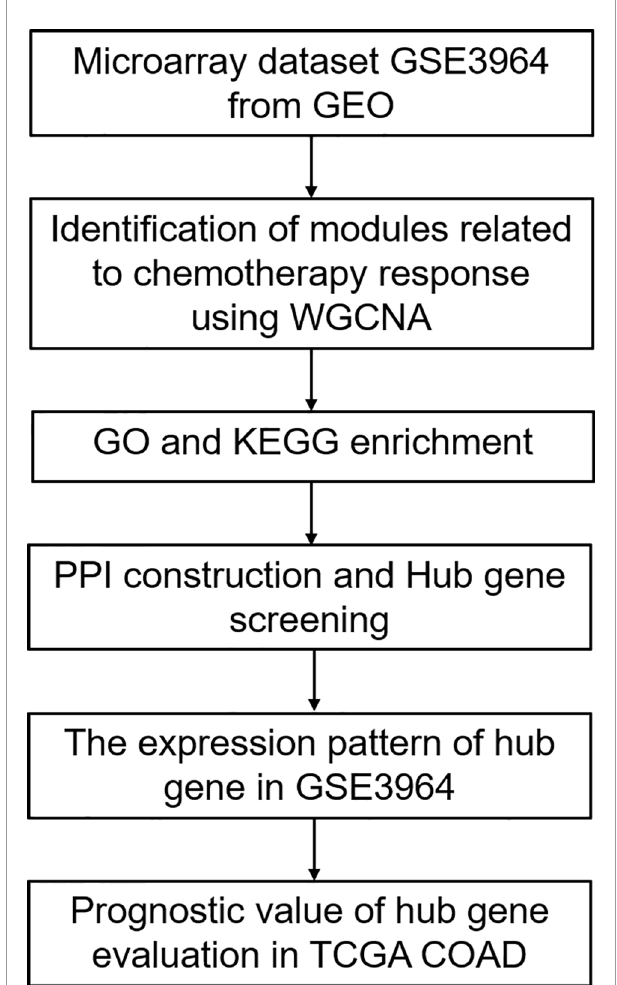
FIGURE 1 | The work fl ow for analyzing the gene related to chemotherapy response in